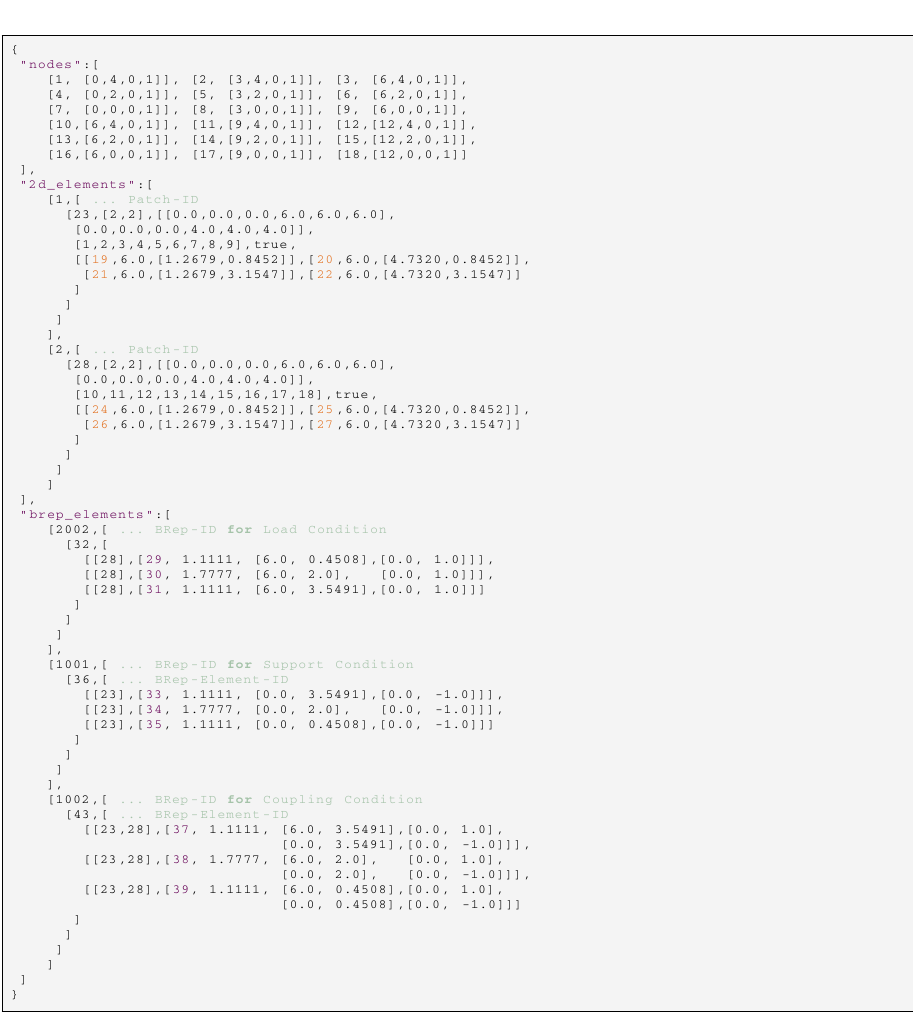
The values ˜ t ξ and ˜ t η are directly read from the exchange format (see Listing 11). They are same for all three quadrature points used for this edge because it is aligned to a parameter direction. The basis vectors can be adapted from “Single patch” section because the geometry is exactly the same as used here. The approximated length of the edge can be computed as follows